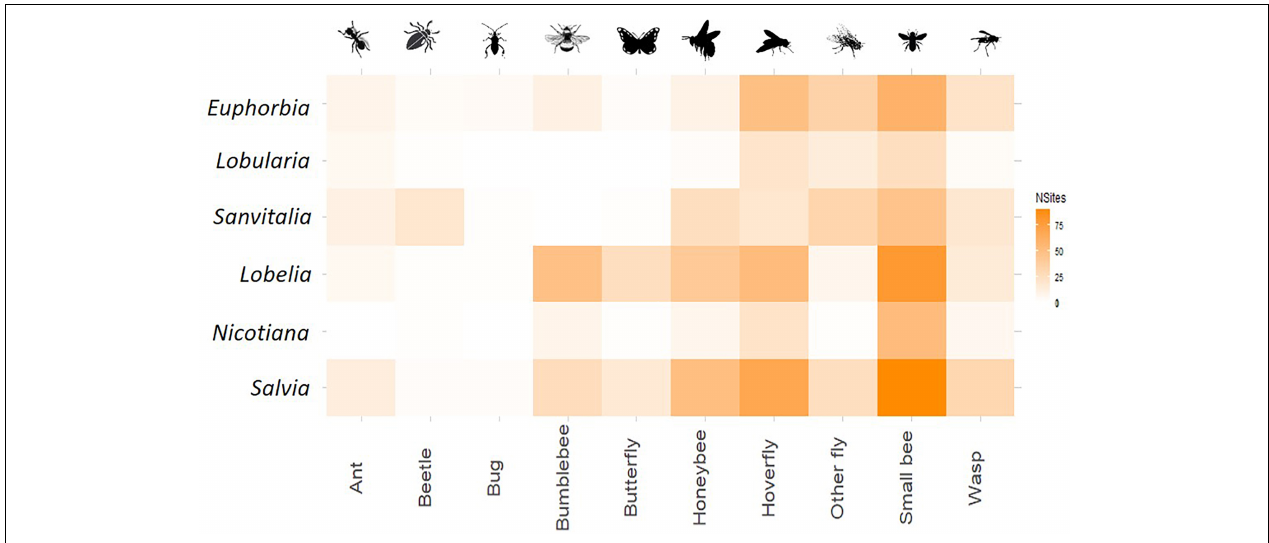
FIGURE 3 | Meta-network of plant–insect interactions across all sites. Weighting of each pairing is given using the number of sites at which the pair was observed to interact, the darker the colour the more consistent the interaction.